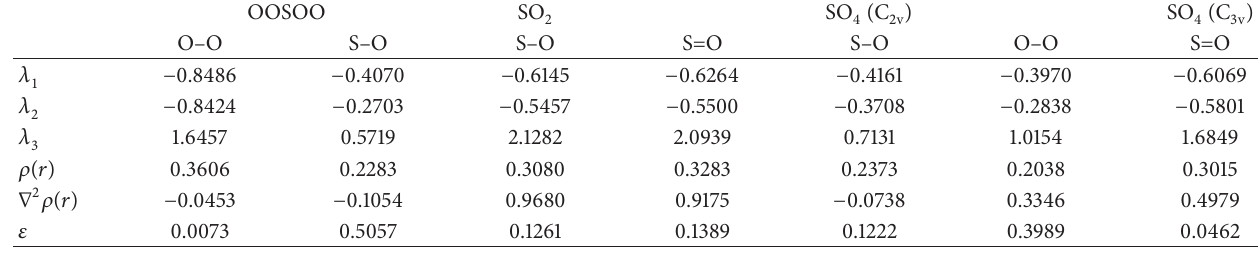
Table 4: Topological analyses of products in atomic units.